Question: In a single sentence, describe what this figure presents.
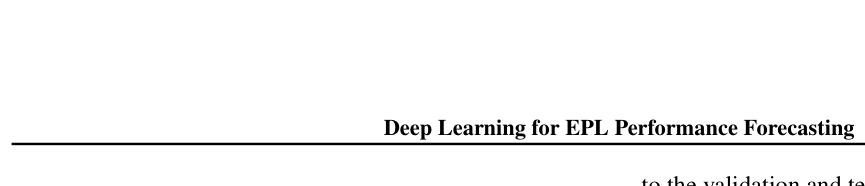
Answer: Forward Predictions vs. True Performance (Holdout Data)